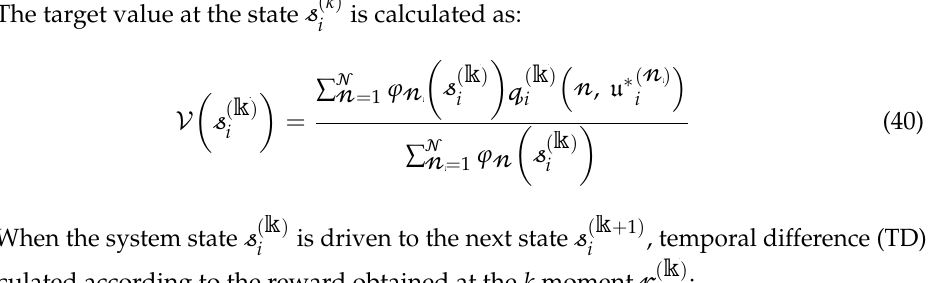
Figure 2. Membership function of fuzzy input of the 𝑖 (cid:3047)(cid:3035) subsystem.